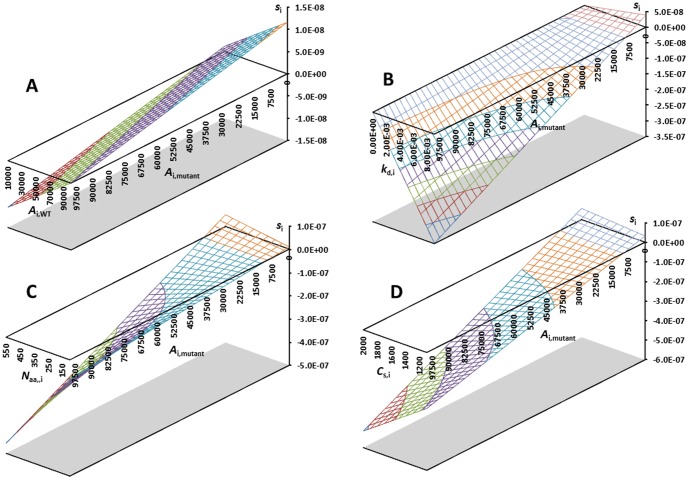
Selection spaces s
i (fitness-differences normalized to wild-type fitness) for mutations causing increased mutant protein expression (A
i,mutant).(A) Selection acts against increased protein abundance of mutant vs. wild-type (A
i,WT) (Default values of parameters from Table 1). (B) High-turnover proteins (with large values of k
d,i) are under stronger selection pressure to perform optimally. (C) For a high-turnover protein (life time ∼1 minute, k
d = 0.01 s−1, larger proteins are under stronger selection to perform optimally, ceteris paribus. (D) Selection pressure is stronger for proteins that are synthetically expensive, as measured by C
s,i (k
d = 0.01 s−1).